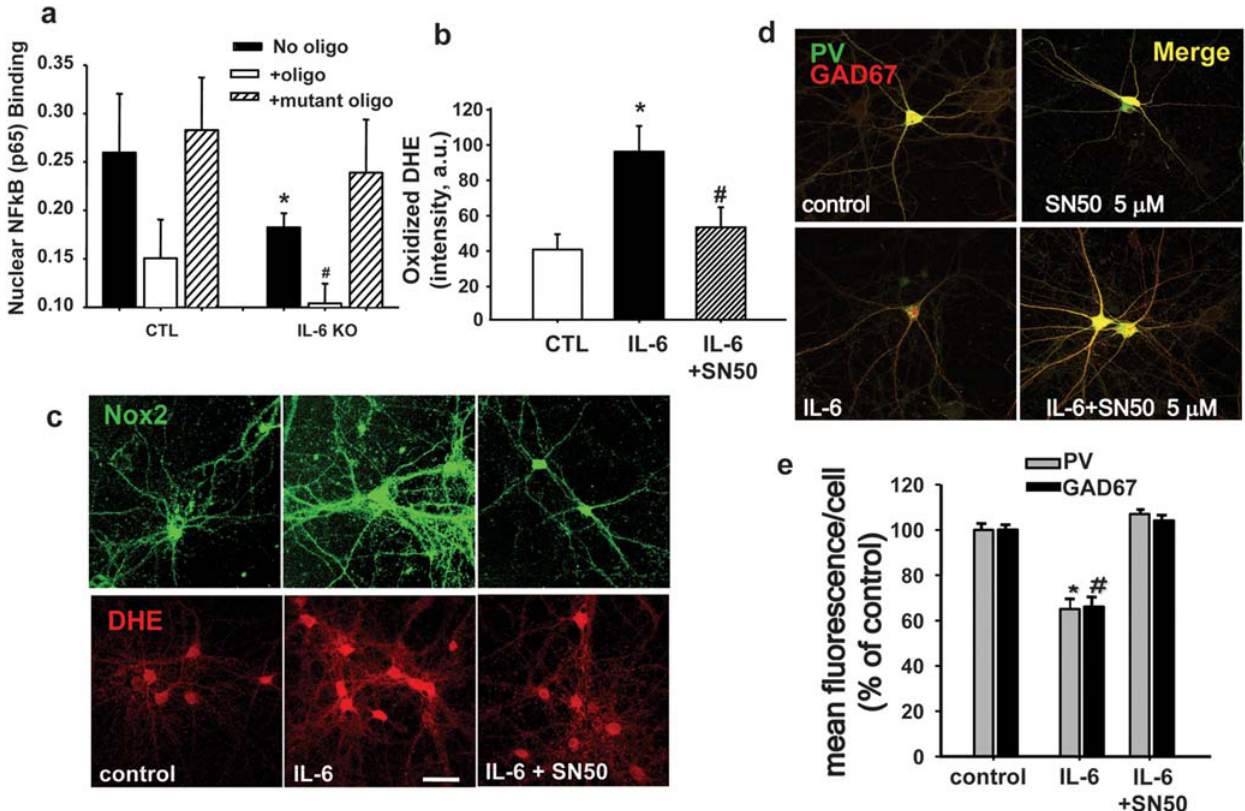
Figure 5. IL-6-induction of Nox2 and subsequent decrease of parvalbumin and GAD67 expression in PV-positive interneurons is NF k B-dependent. Nuclear extracts of brain samples obtained from wild-type or IL-6-deficient animals were analyzed for content of the NFkB p65 subunit by colorimetric quantification of p65 using a commercially available kit (TransAM). A high concentration of p65 was found in nuclear extracts obtained from old wild type mice (a), and this was greatly diminished in nuclear extracts obtained from similar-age IL-6 deficient mice. The specificity of the binding to wild type oligonucleotide was confirmed by competition with either sense (oligo) or mutated oligonucleotides (mutant oligo). ANOVA analysis yielded a significant effect of genotype (F (1,18) =9.414, P , 0.05). (b) Application of IL-6 to neurons in culture induced Nox2 expression (b, top panel) and DHE oxidation (b, bottom panel and c) that was blocked by the NF k B inhibitor SN50. Dissociated primary neuronal cultures were treated with IL-6 (10 ng/ml) for 24 h in the absence or presence of SN50 (5 m M), an inhibitor of NF k B nuclear translocation. Dihydroethidium (DHE, 1 m g/ml) was applied for the last hour as described[18]. After fixation, cells were immunostained for Nox2. *=significant with respect to control. # =significant with respect to IL-6, F (2,346) =12.826, P , 0.05). (d. e) SN50 also prevented the decrease in expression of parvalbumin and GAD67 induced by IL-6 exposure in PV-interneurons (*F (2,409) =234.7, P , 0.05; # F (2,409) =192.8, P , 0.05).